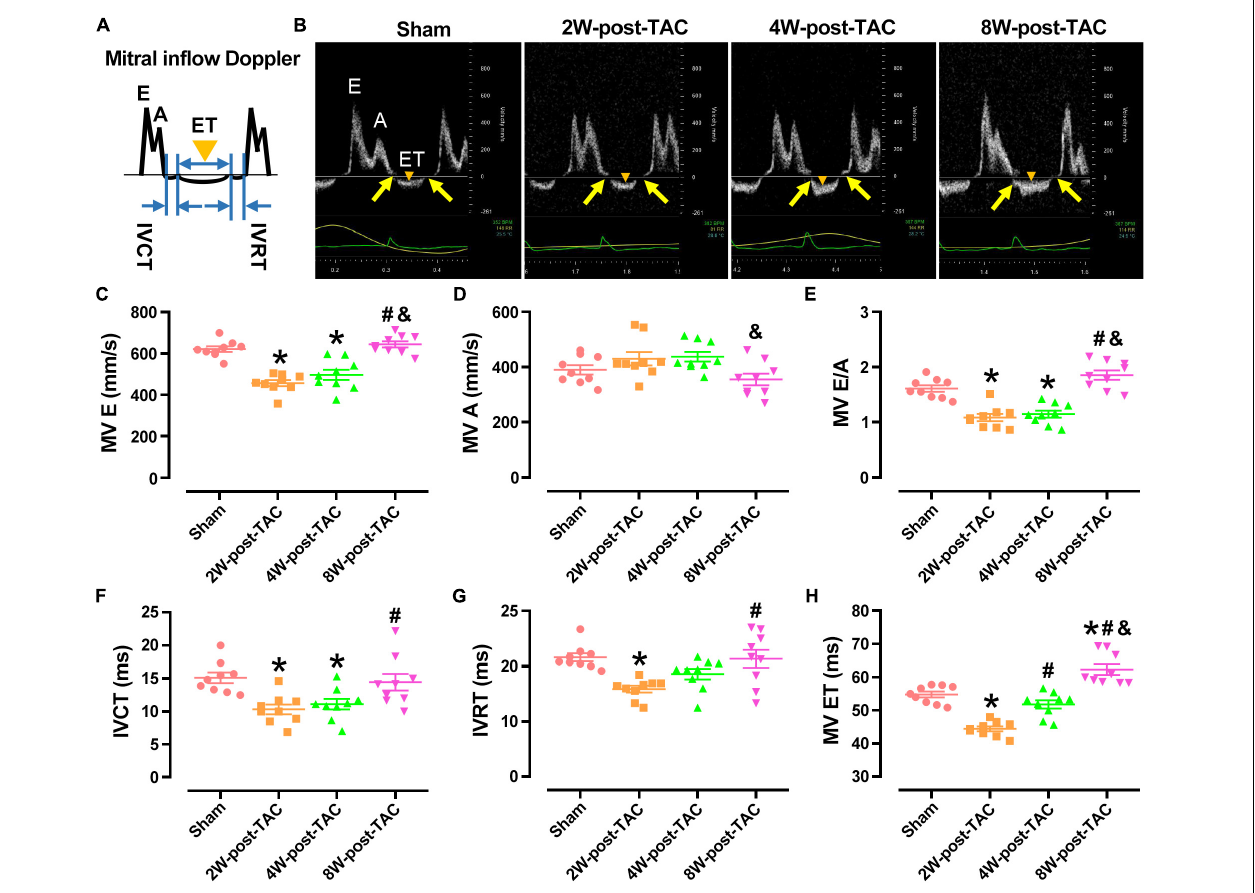
FIGURE 3 | Indices of mitral inflow Doppler. A carton of and representing images of mitral inflow Doppler was displayed in panels (A,B) , respectively. The peak E-wave velocity (MV E) had decreased in the 2W and 4W-post-TAC groups (C) . The peak A-wave velocity (MV A) did not significantly differ among groups (D) . The MV E: A ratios had decreased in the 2W- and 4W-post-TAC groups but non-significantly increased ( P = 0.0786) in the 8W-post-TAC group (E) . The isovolumetric contraction time (IVCT; F ), isovolumetric relaxation time (IVRT; G ), and ejection times (MV ET; H ) had decreased in the 2W-post-TAC groups but elevated in the